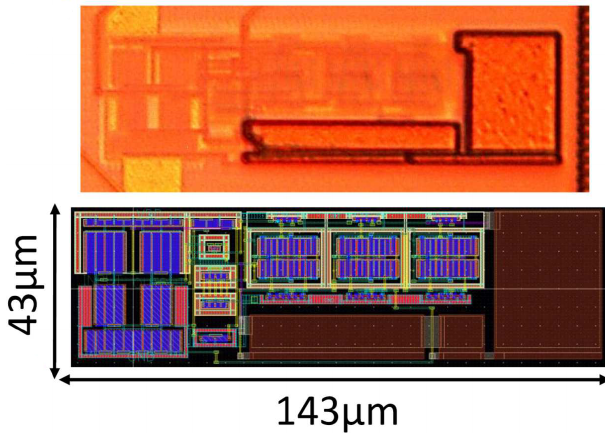
Figure 10. Integrated self-biased current buffer SB-CB2.